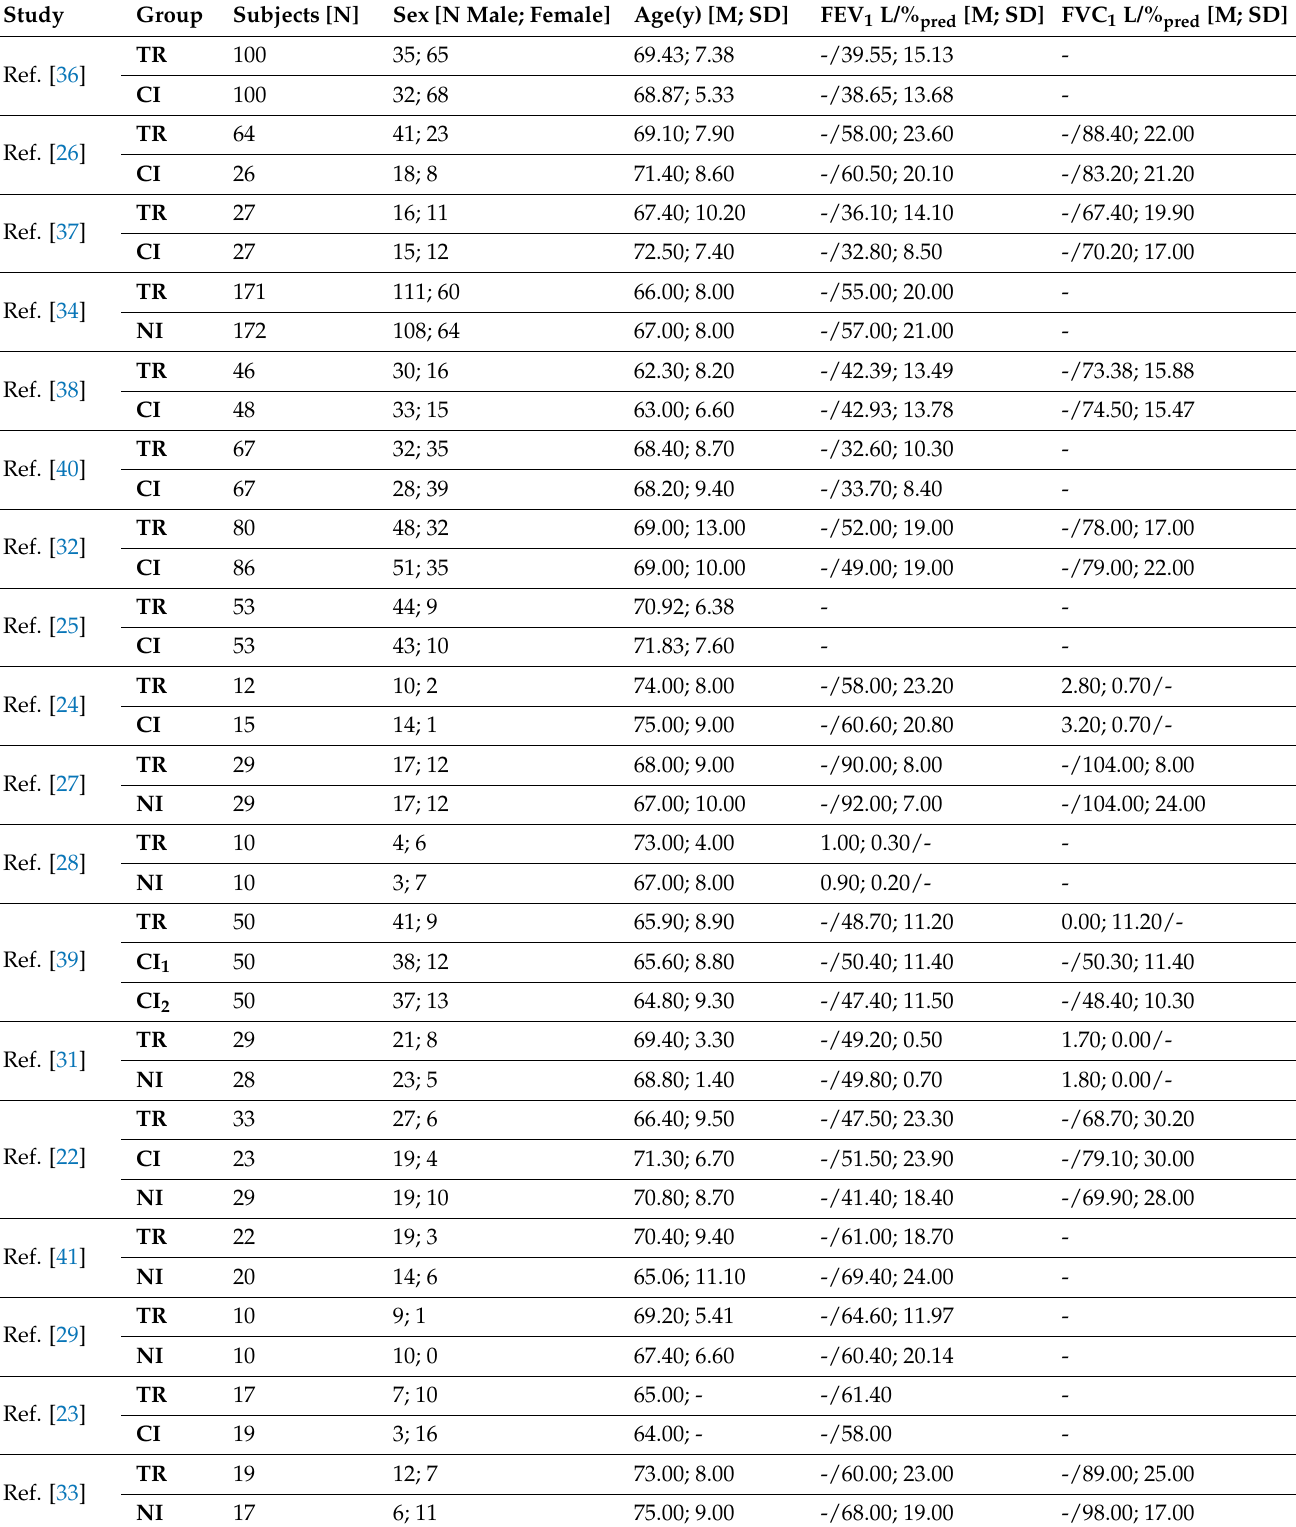
Table 2. Demographics and clinical characteristics of the experimental and control groups of the trials included in the systematic